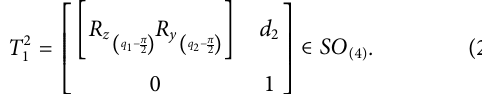
Frontiers in Robotics and AI |